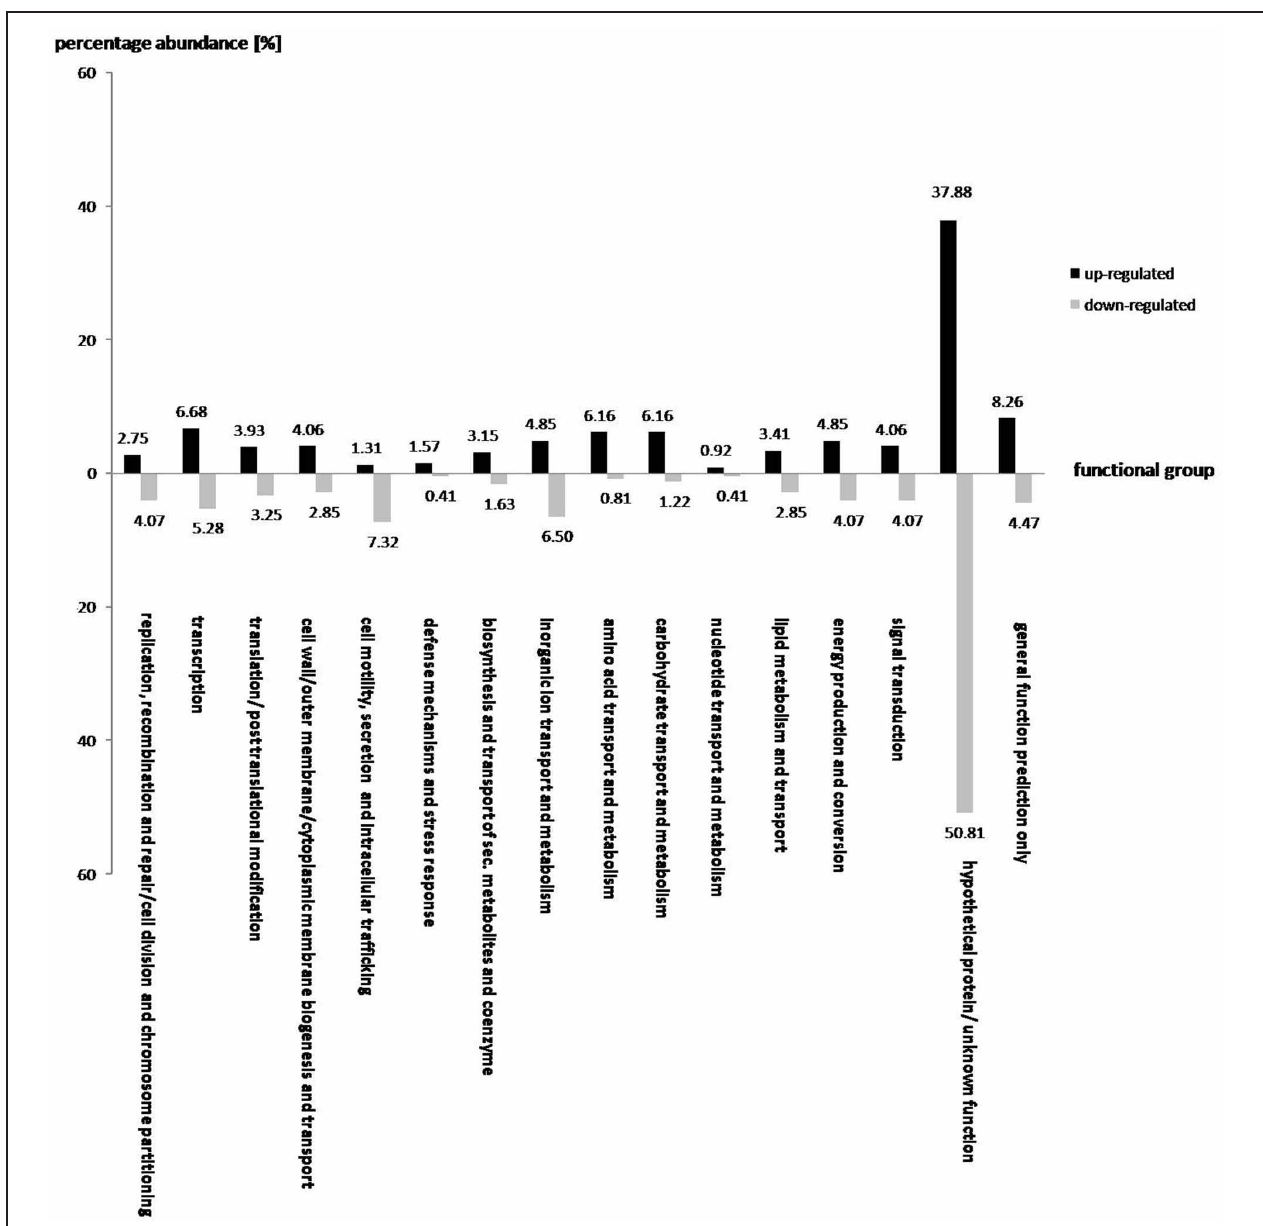
involved in cell wall, outer-membrane or cytoplasmic membrane biogenesis and transport as well as genes responsible for the transport of secondary metabolites and coenzymes are mainly up-regulated. In contrast, genes involved in cell motility and secretion, and those responsible for the transport and metabolism of inorganic ions are mainly down-regulated. The value above each column corresponds to percentage abundance of the corresponding functional group in the total count of the up or down-regulated